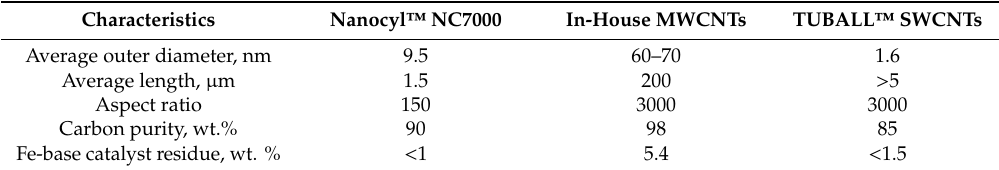
Table 5. Characteristics of different type of CNTs.